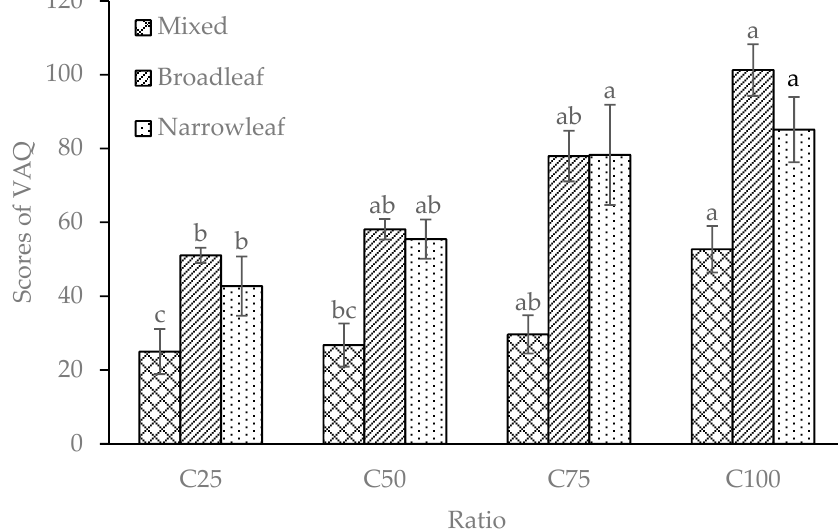
Table 5. Interaction terms by a mixed two-way ANOVA with repeated measures (“Setting × Color Proportion” and “Setting × Spatial Distribution”).